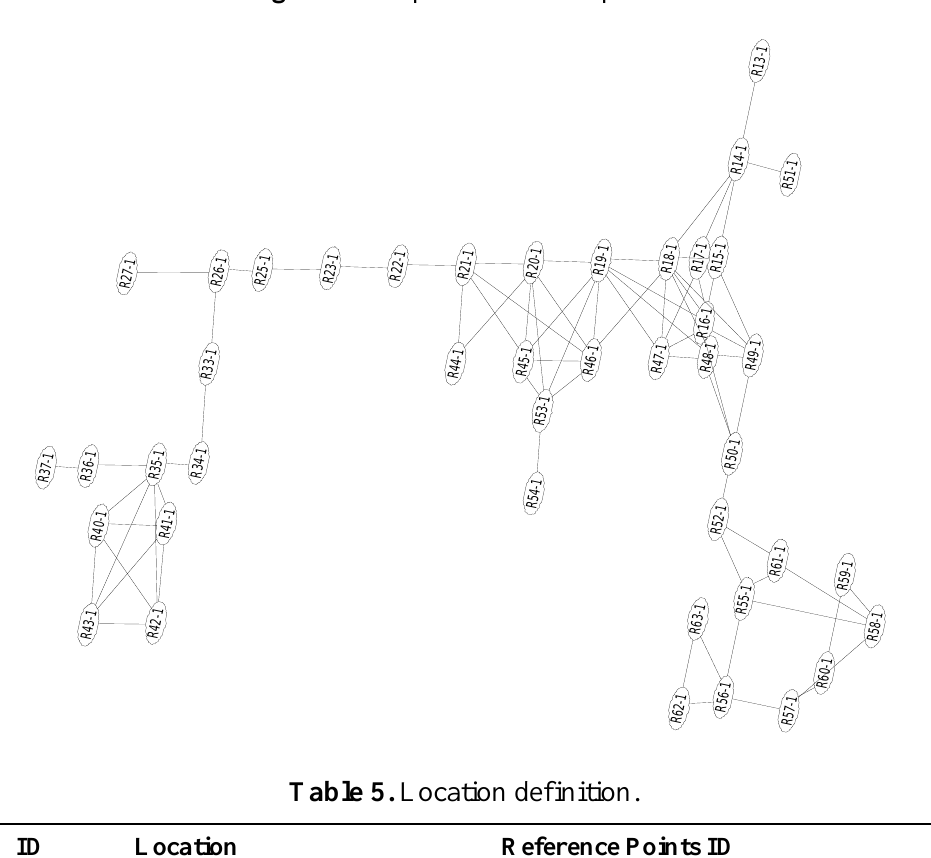
Figure 9. Graph of reference points.